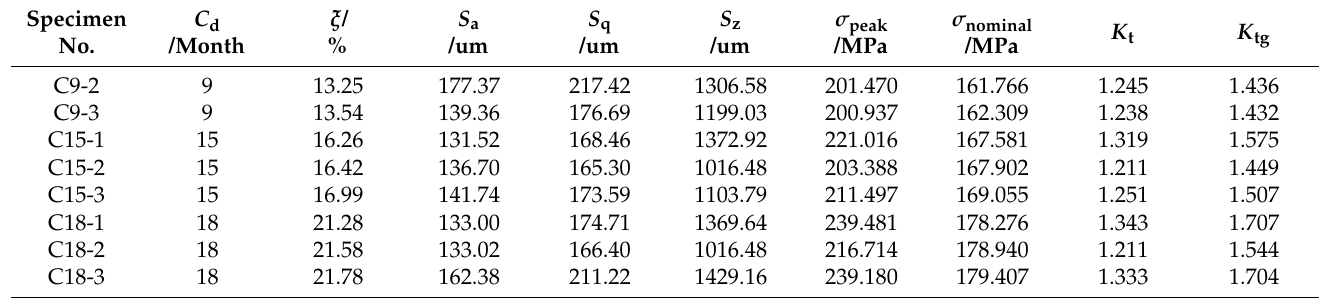
Figure 2. Three-dimensional surface profile measurements: ( a ) photograph of corroded steel plates after removing corrosion products, ( b ) photograph of surface morphology scanning test, ( c ) dimen- sions of cut dog-bone specimen and scanning area (mm).